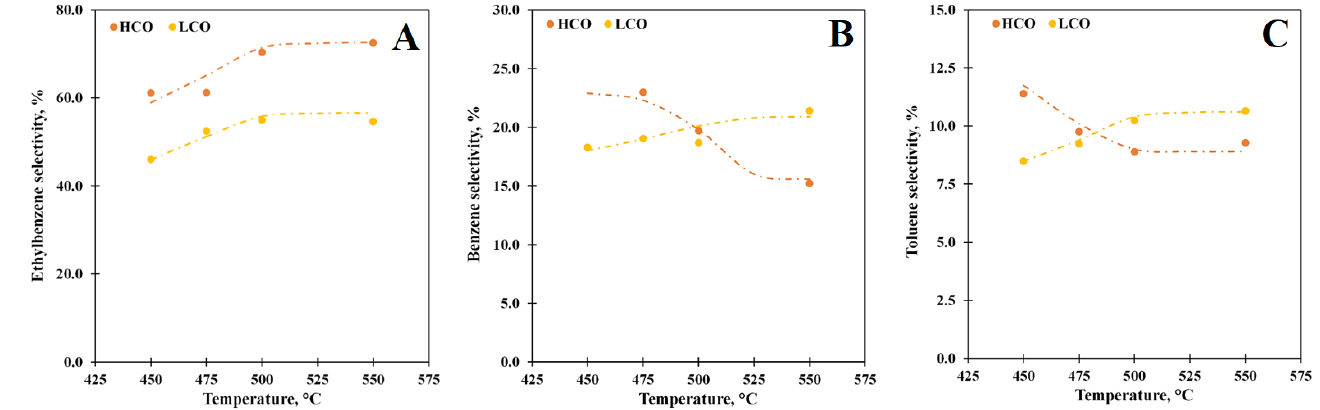
Figure 4. The ethylbenzene ( A ), benzene ( B ), and toluene ( C ) selectivity vs. temperature at WHSV 85 h − 1 for the PS solutions in LCO (15% PS) and HCO (10% PS)